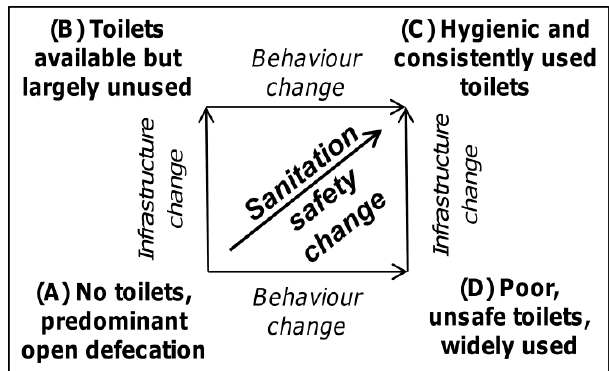
Figure 1. Different pathways to sanitation safety. Source: Produced by the authors.